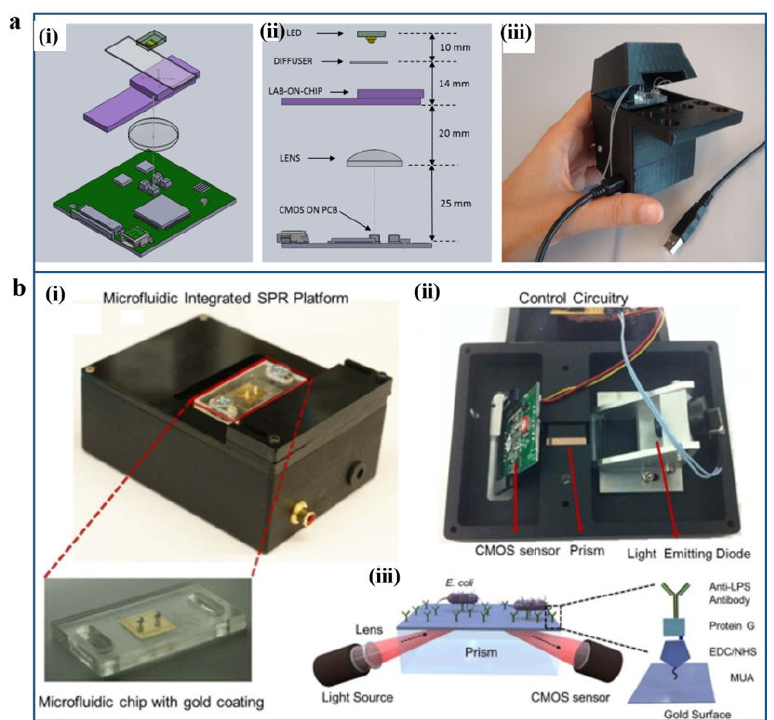
Figure 7. ( a ) Custom-made T-LSPR biosensing device. ( i ) Scheme of the different components in the T-LSPR setup. ( ii ) Side view of the T-LSPR setup with relative distances indicated. ( iii )